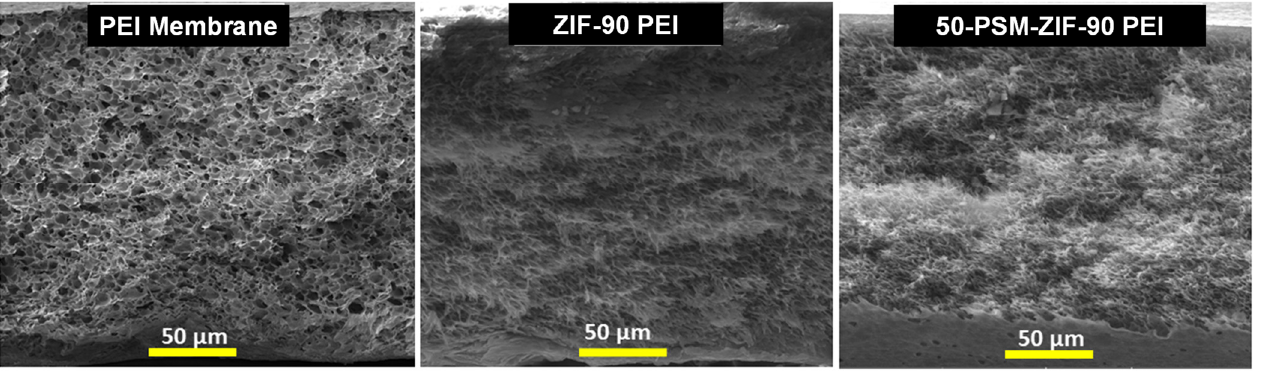
Figure 8. Cross-section FESEM images of Pure PEI membrane, ZIF-90 PEI and 50-PSM-ZIF-90 PEI membranes.